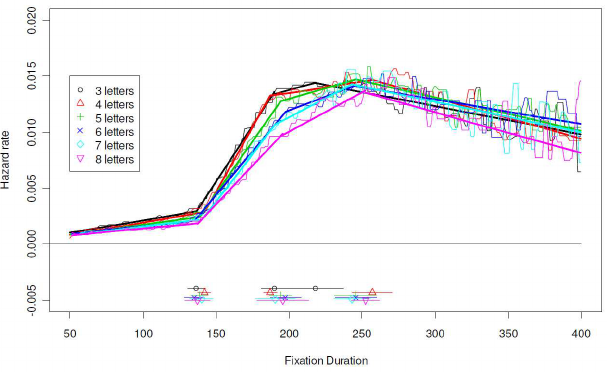
Figure 7. Effect of Word Length (Dundee